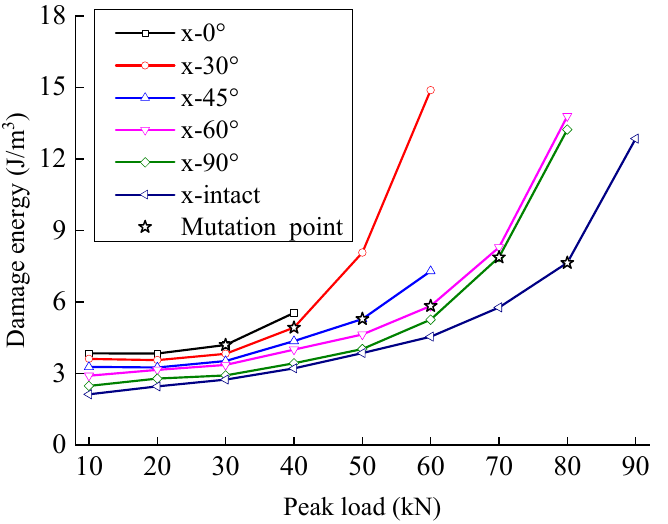
Figure 14. Damage energy evolution curve of sandstone with different crack angles.